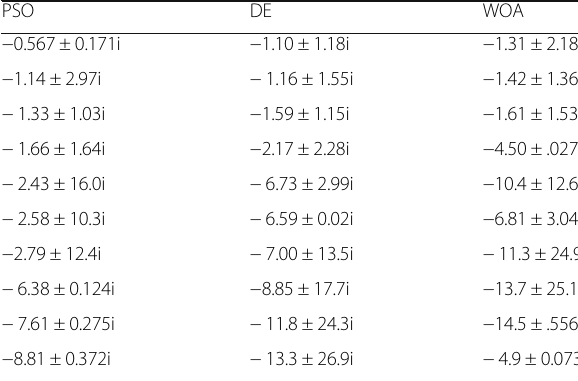
Table 6 Eigen value analysis of two area